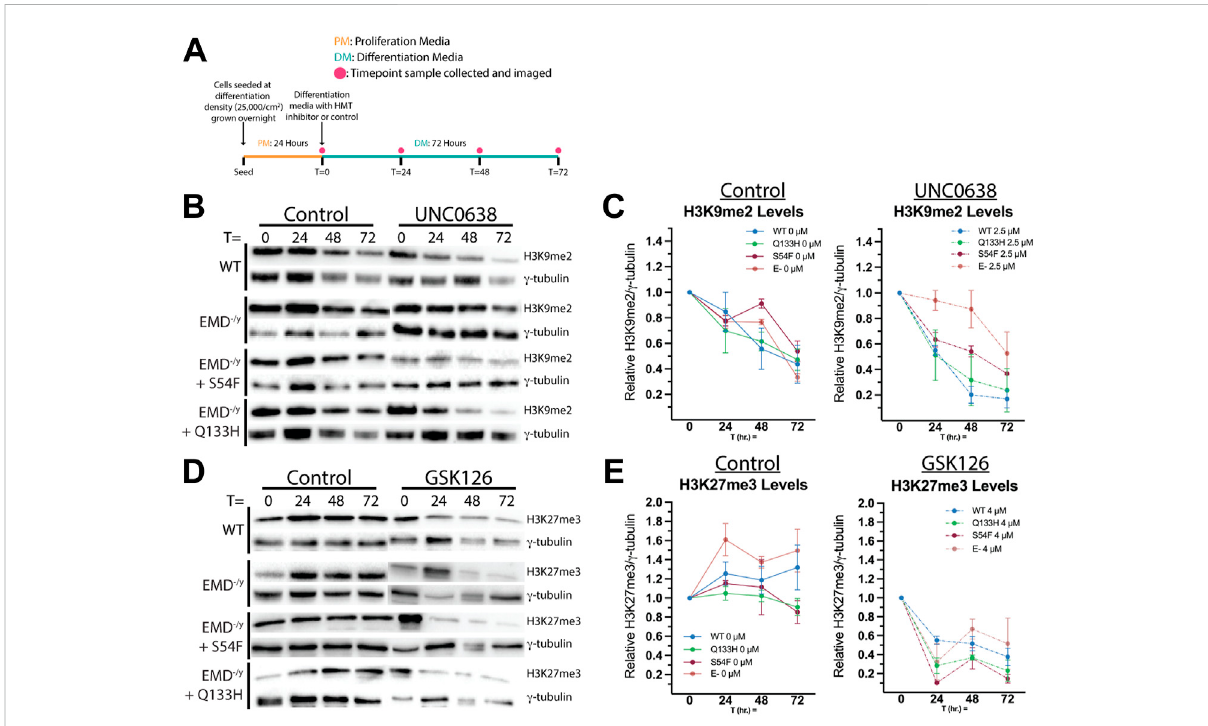
FIGURE 4 H3K9me2 and H3K27me3 are reduced by histone methyltransferase inhibitors throughout differentiation. (A) Schematic of the experimental approach for validating inhibitors UNC0638andGSK126 isshown. Wildtype, emerin-null(E-), S54F,or Q133Hmyogenic progenitors wereseededat 25,000cells/cm 2 andgrownovernightinproliferationmediaat10%CO 2 and33 ° C.Att=0 h,differentiationwasinducedbyreplacingthemediawith differentiation media and incubating at 5% CO 2 and 37 ° C. Differentiation media contained 2.5 uM UNC0638, 4 uM GSK126, or ethanol alone. Images and samples were collected at 0, 24, 48, and 72 h. UNC0638 (B) and GSK126 (D) samples were separated by SDS-PAGE and visualized by westernblot.Quantitationwasperformed via densitometryanalysisofH3K9me2[ (C) ; n =2]andH3K27me3[ (E) ; n =2]ateachtimepointandplotted. Bands were normalized to γ -tubulin expression. Error bars represent